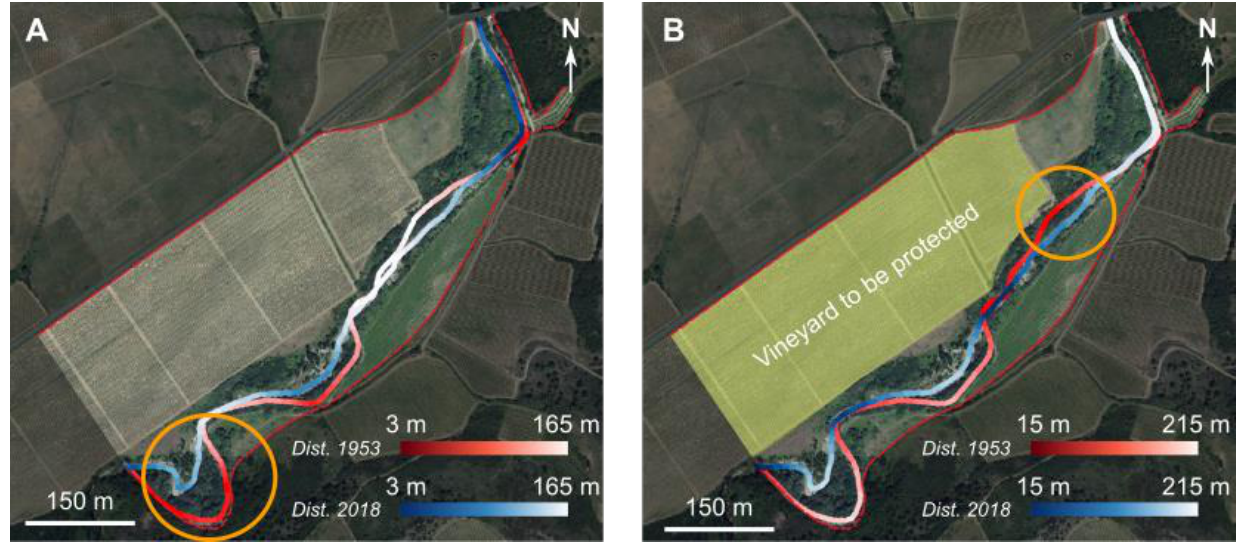
Figure 10. Indicator 1 in a perspective of fluvial dynamics study ( A ) and in a perspective of risk management ( B ) in the Clamoux River.